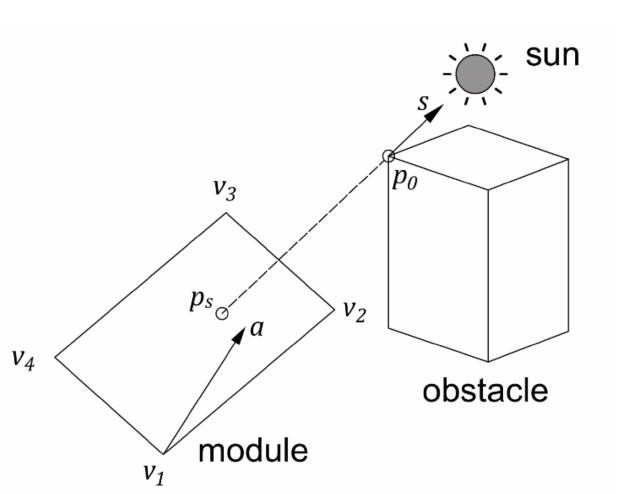
Figure 4. A vertex p 0 of one obstacle is projected on the plane defined by the module. The projected point is called p s . The vector s is a vector pointing towards the sun. The vector a is normal to the plane of the module. v 1 , v 2 , v 3 , and v 4 are the positions of the vertices that define the